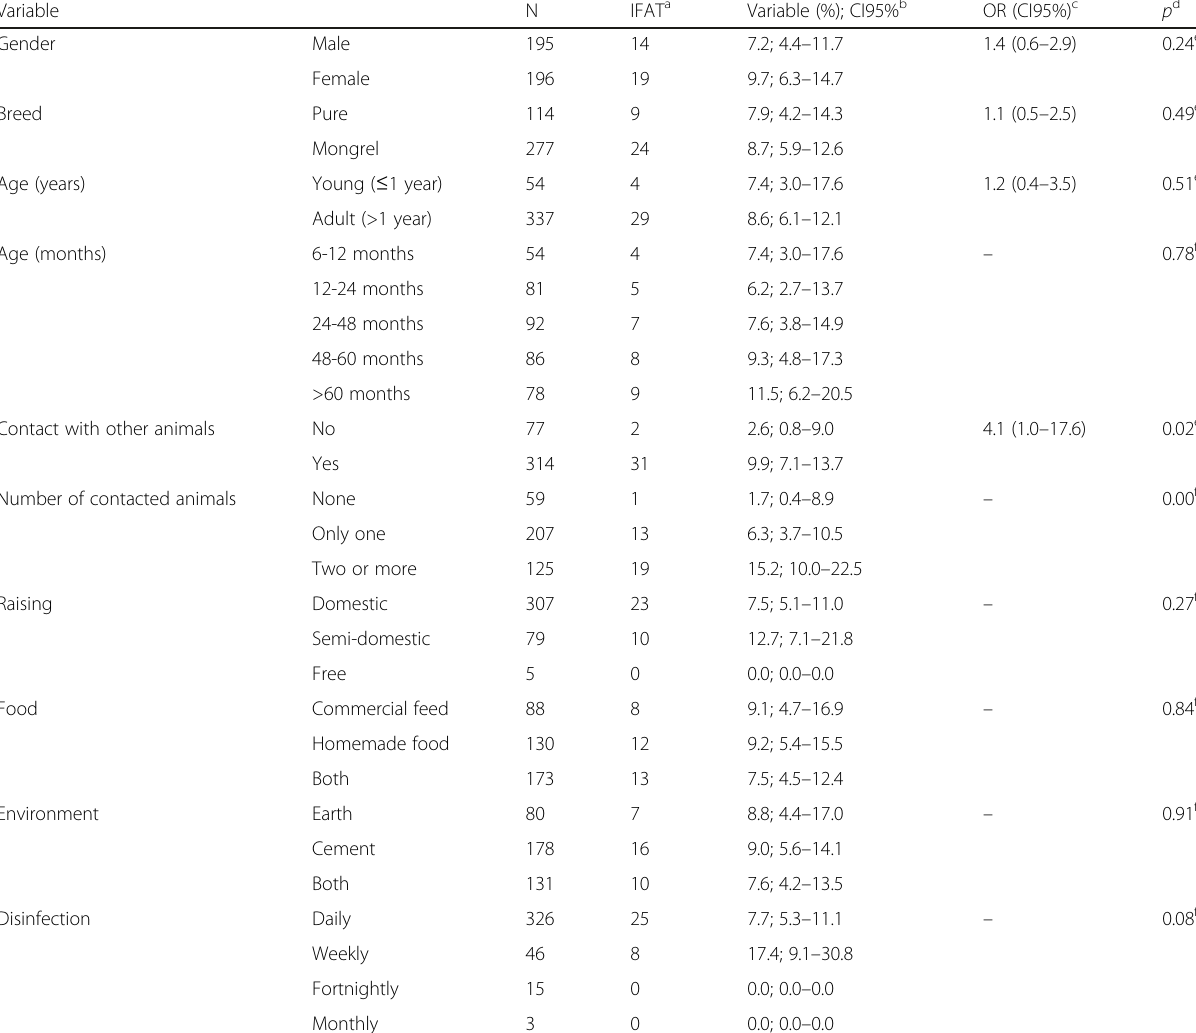
Table 1 Association between IFT-Lm results and epidemiological variables investigated in the studied animals